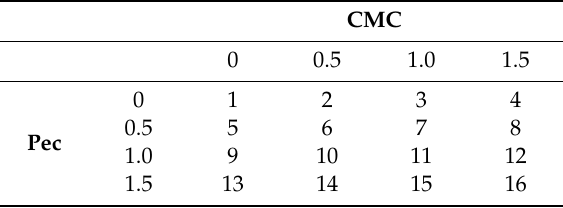
Table 1. Treatment combinations of carboxymethylcellulose (CMC) (%) and pectin (Pec) (%) on fruits.